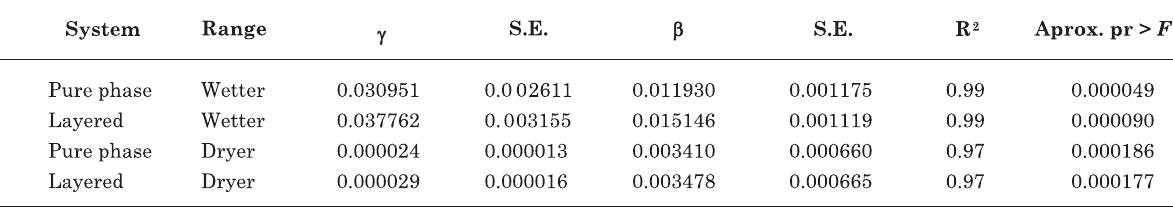
Table 2. Statistical parameters for nonlinear regression fitting of eq. (8) to drier range hydraulic conductivity vs. head difference (upper BC – lower BC)